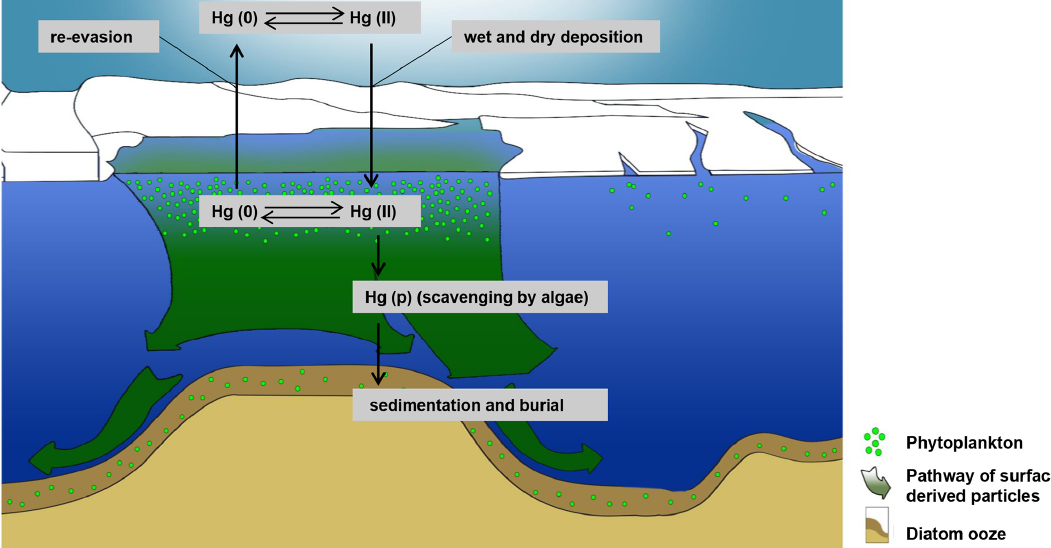
Figure 8. Adélie Basin schematic Hg cycle model indicating the processes controlling Hg deposition and accumulation under high primary production. Fast-sinking diatom particles remove dissolved water-phase Hg from the water column through scavenging (figure is adapted from Jansen et al.,